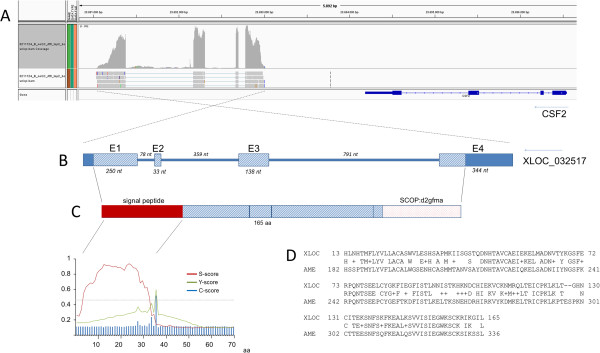
Structural features of the novel bovine locus XLOC_032517. A: Assignment of reads in the genomic region BTA7:23 691 000 Mb – 23 697 000 Mb visualised by Integrative Genome viewer. Annotation and orientation of the bovine CSF2 gene is indicated according to the NCBI Btau 6.1 assembly [33]. B: Genomic structure of XLOC_032517. Boxes indicate exons (E1-E4). Solid blue colour indicates the predicted 5’and 3’UTR, shaded pattern indicates an open reading frame with the predicted coding sequence. C: Structure of the predicted XLOC_032517 protein with signal peptide (red colour) and d2gfma motif (red dotted pattern). Significant evidence of the signal peptide motif is obtained by calculation of S-, Y-, and C-scores with SignalP [34]. D: Homology of the predicted XLOC_032517 amino acid sequence (XLOC) with the predicted great panda LOC100473502 amino acid sequence (AME) as determined by BLASTP [33].